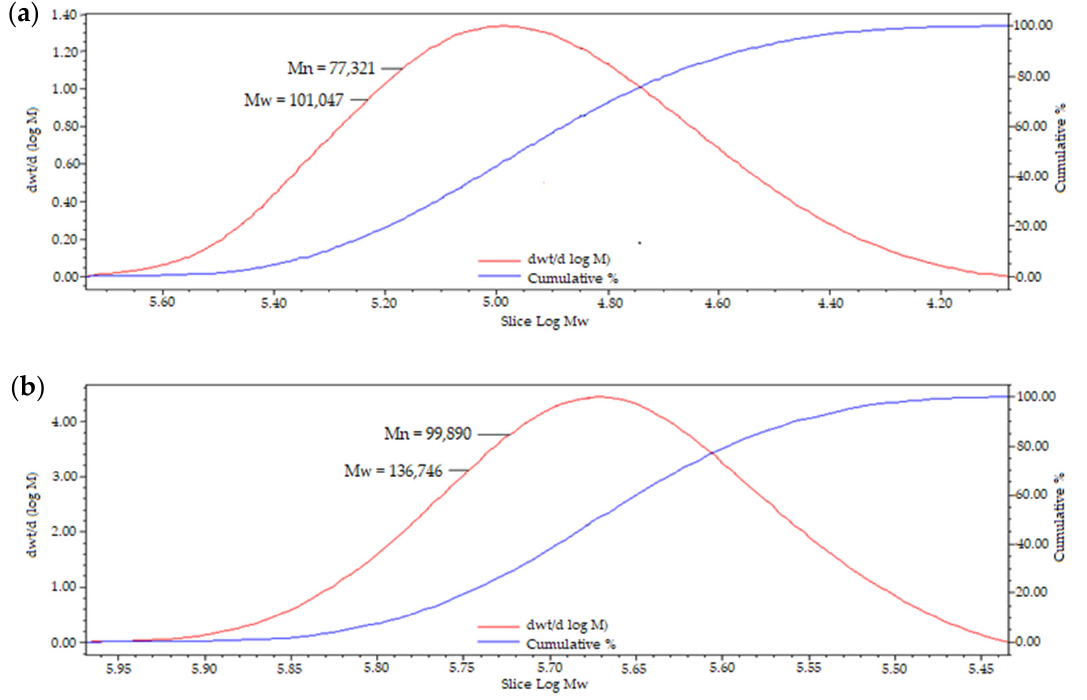
Figure 7. Representative GPC chromatogram of ( a ) native pullulan and ( b ) BMO-PUL (DG 33.8%). Table 3. BMO-PUL derivatives viscosity data ( n = 3; ±